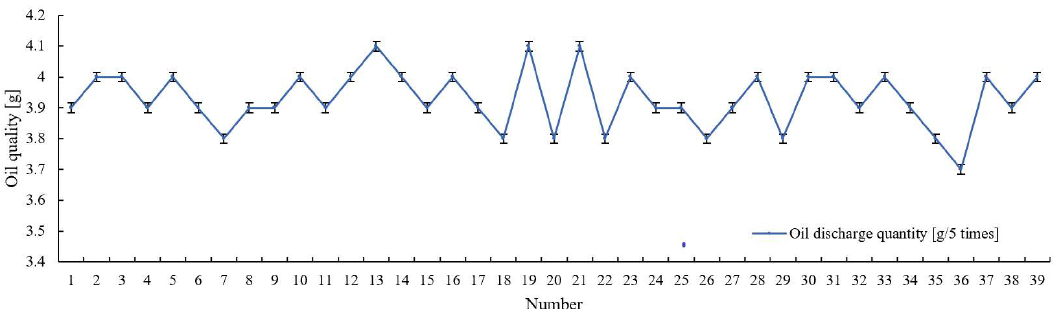
Figure 12. Oil discharge pressure of the grease suction and drainer devices after 12,000 fatigue tests.